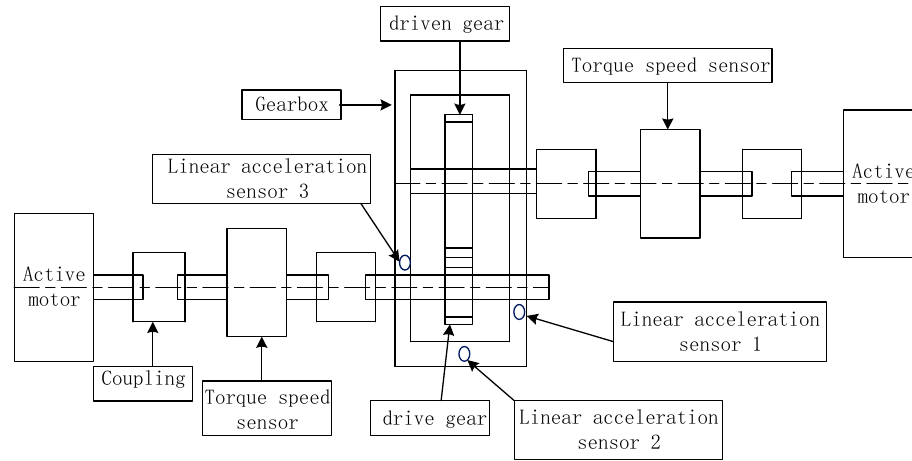
Figure 10. Structural design of the gear test bench.